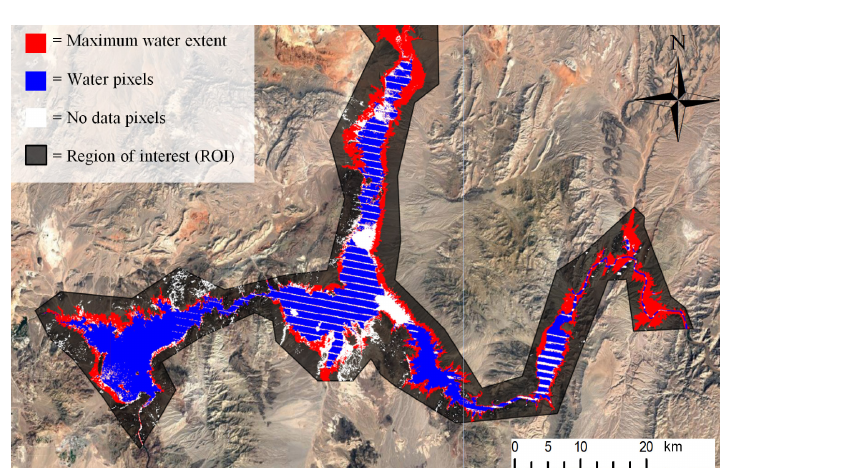
Figure 2. An example of the area input data for Lake Mead (US) for February 2015, where the maximum water extent is marked as red, water as blue and a lack of data as white